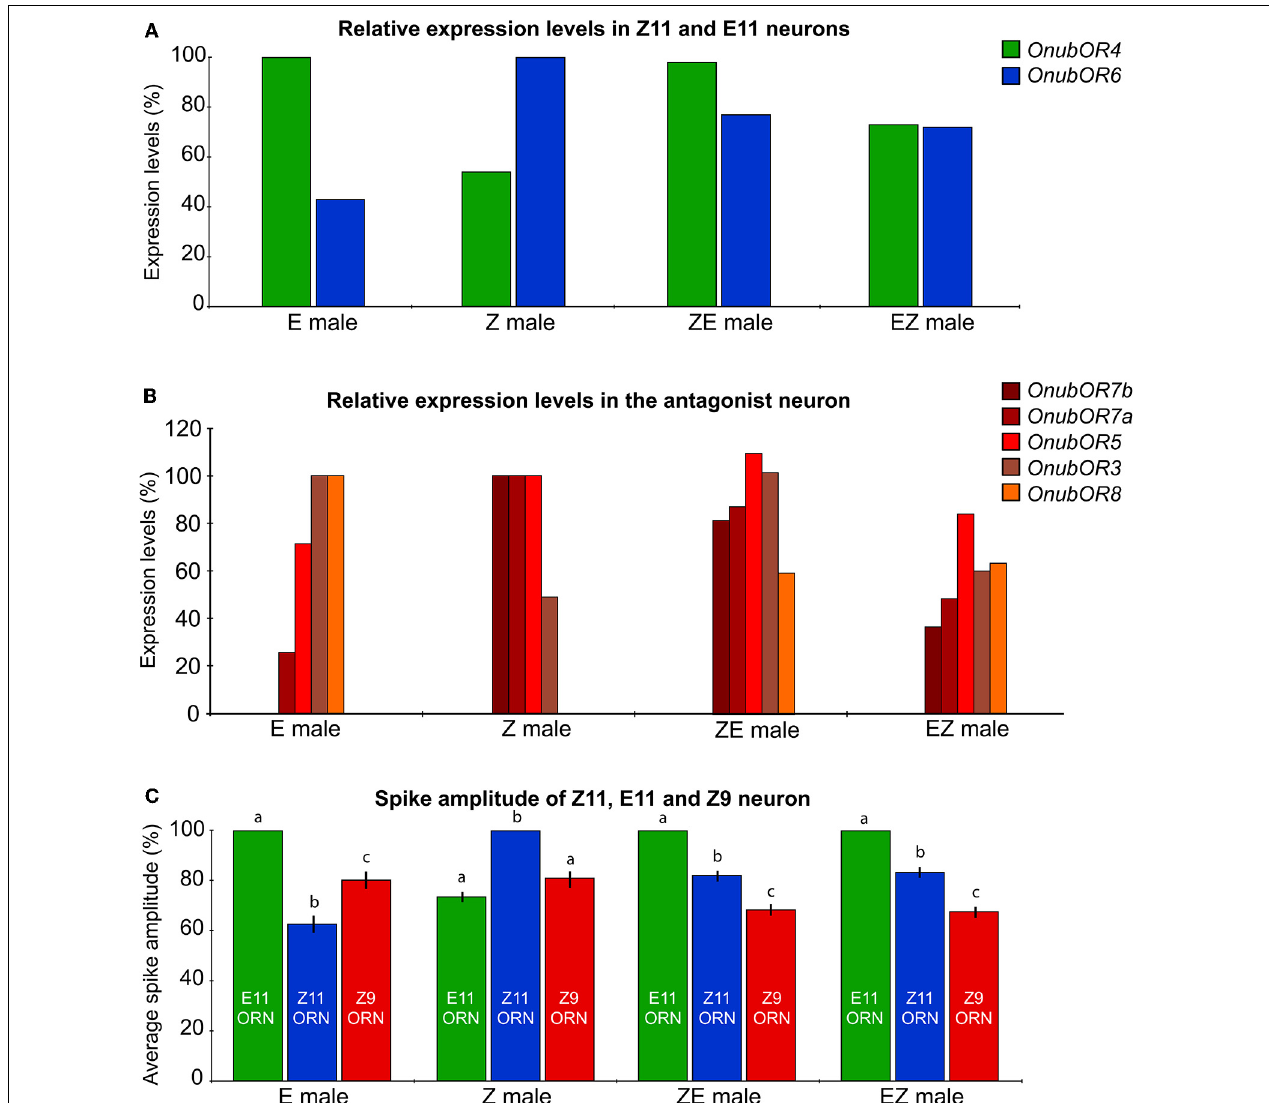
FIGURE 4 | Comparison of pheromone receptor expression level and spike amplitudes in pheromone strains and hybrids. (A) Expression levels (%) of OnubOR4 and OnubOR6 , detecting E11, and Z11, respectively, in male antenna (from left to right E-strain, Z-strain and two hybrids, male expression levels). (B) Expression levels, in antennae of male, female, Z-strain, E-strain and hybrids, of the four co-expressed pheromone receptor genes (including